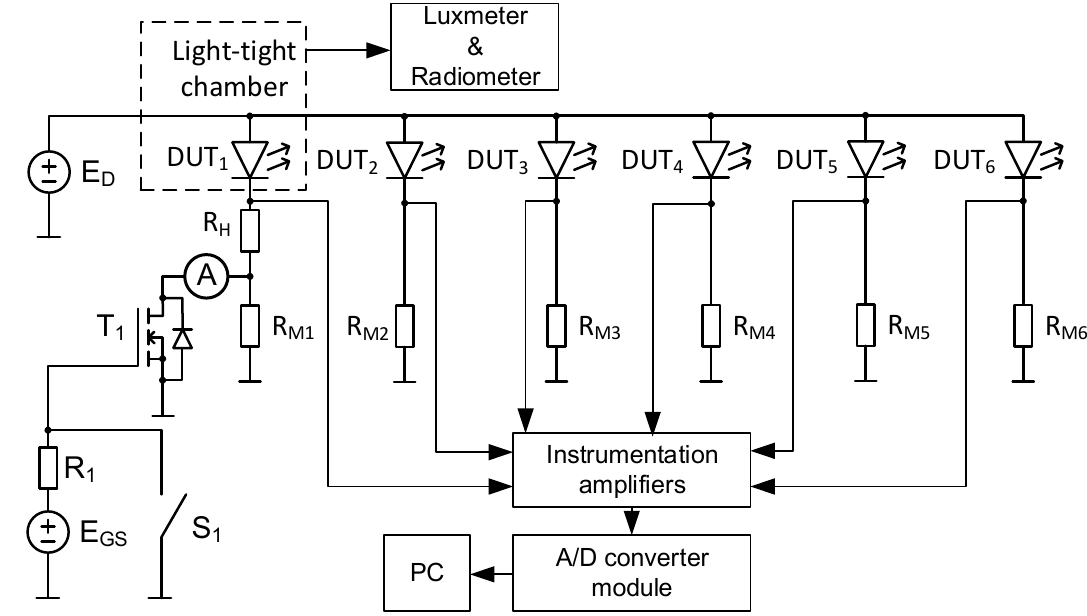
Figure 5. Diagram of the measurement set-up dedicated to thermally coupled diodes.